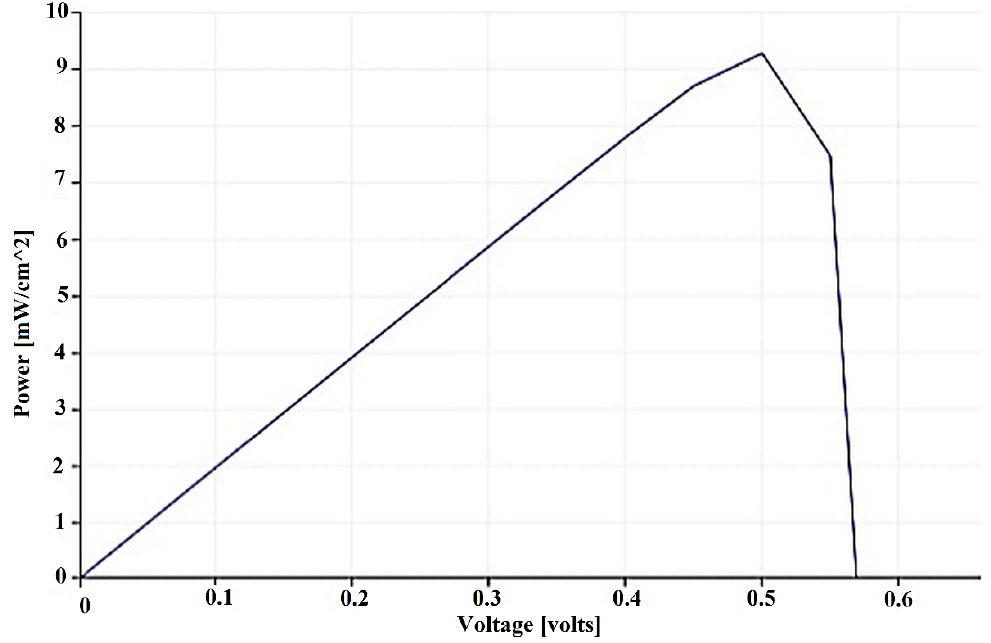
Figure 5. Voltage-based output power curve for PSC designed with gaphene nanoribbon .